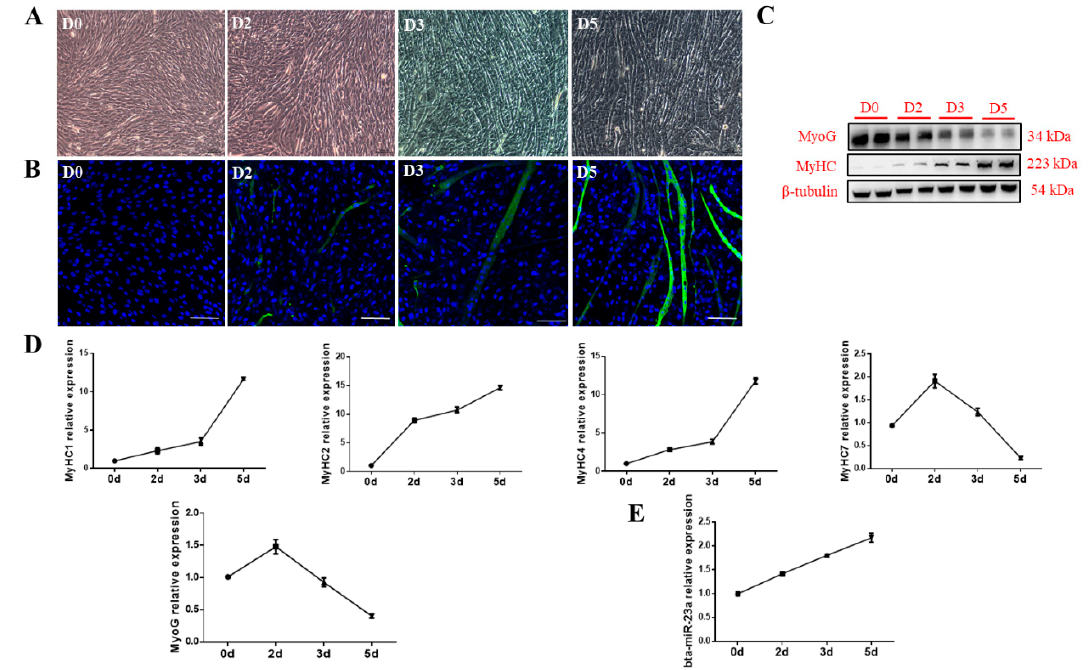
Figure 2. bta-miR-23a expression increased during myogenic differentiation (MD) of PDGFR α− bPCs. ( A ) Morphological features of PDGFR α− bPCs at Day 0 (D0), 2 (D2), 3 (D3) and 5 (D5) after MD. Scale bar represents 100 μ m. ( B ) MyHC positive cells (green) at D0, D2, D3 and D5 after MD were examined by fluorescence microscopy. Scale bar represents 100 μ m. The protein ( C ) and mRNA ( D ) levels of MyoG and MyHC. β -tubulin was used as the reference gene. ( E ) Relative expression of bta-miR-23a at D0, D2, D3 and D5 after MD. Results are representative of the mean (± SD) of three independent analyses.